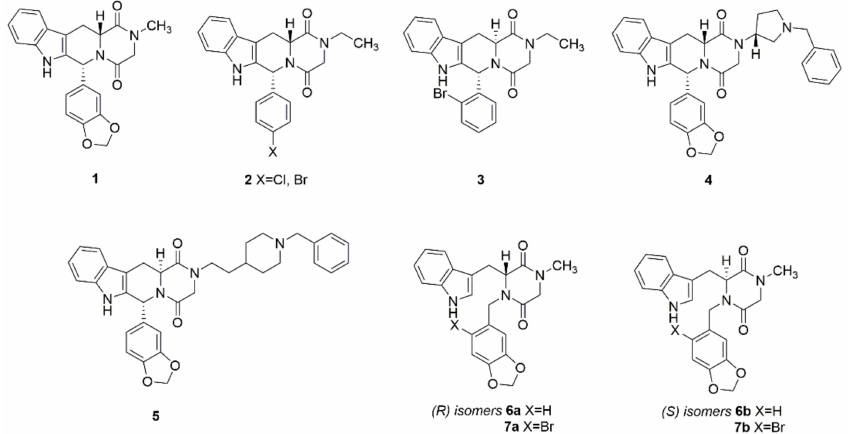
Figure 1. Tadalafil ( 1 ), its equipotent phosphodiesterase 5 (PDE5) inhibition analogues 2 , analogues with cytotoxic 3 , antiplasmodial 4 , procognitive 5 activities and newly synthesized compounds 6a,b and 7a,b